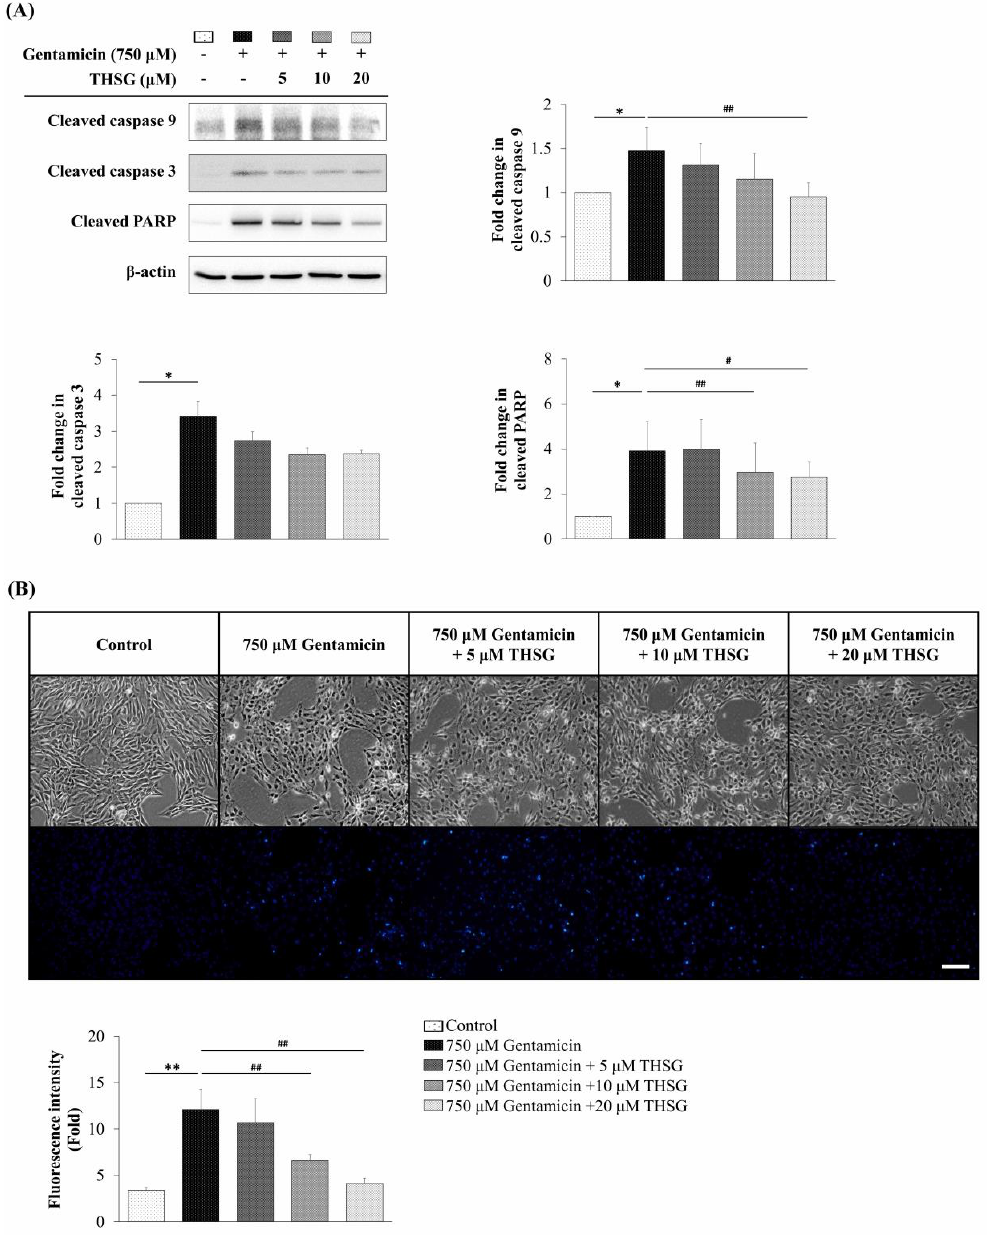
Figure 4. Effects of THSG on gentamicin-induced apoptotic protein expression and nuclear condense in mouse cochlear UB/OC-2 cells. Cells were treated with various THSG concentrations for 6 h, followed by 750 μM gentamicin for 48 h. ( A ) Protein levels of cleaved caspase 9, cleaved caspase 3, and cleaved PARP were analyzed by western blotting. ( B ) Nuclear apoptotic changes were assessed using Hoechst 33258 fluorescence dye. Scale bar = 50 μm. Images were obtained using a fluorescence microscope. All data are expressed as the means ± standard deviation from three independent experiments. * p < 0.05, ** p < 0.01 vs. the control group; # p < 0.05, ## p < 0.01 vs. the gentamicin-treated group.